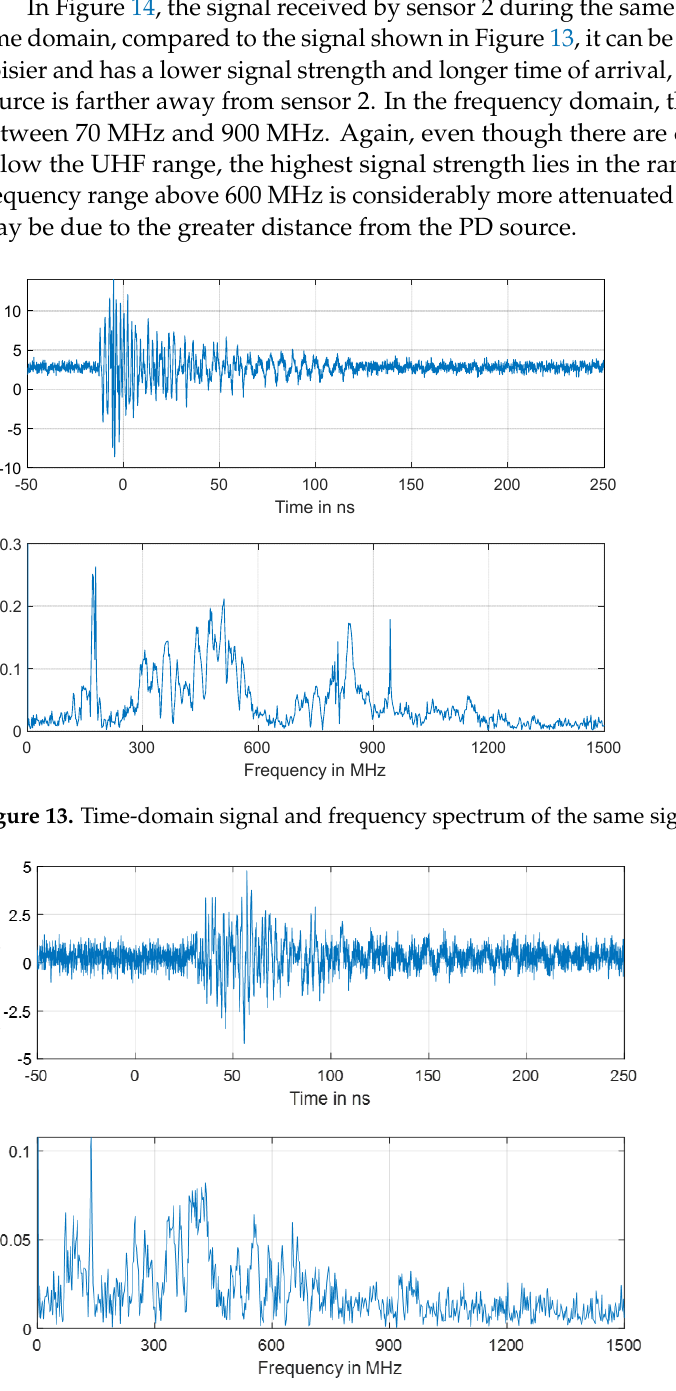
Figure 14. Time ‐ domain signal and frequency spectrum of the same signal obtained from sensor 2.